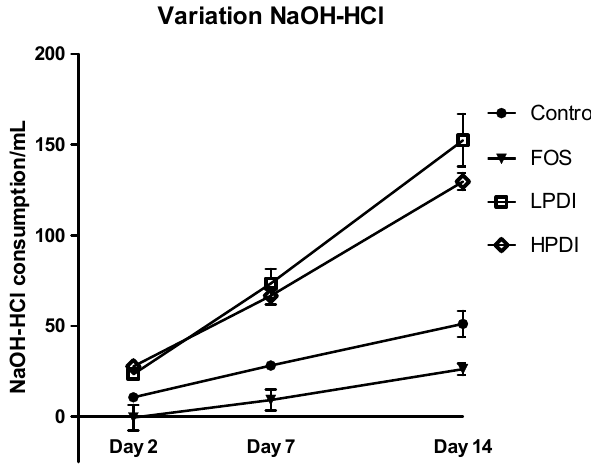
Figure 5. Total acidification activity, expressed as the difference in mL of the consumption of NaOH and HCl required to keep the system’s pH stable, for the different fructans (FOS, LPDI, and HPDI) and the control treatment.